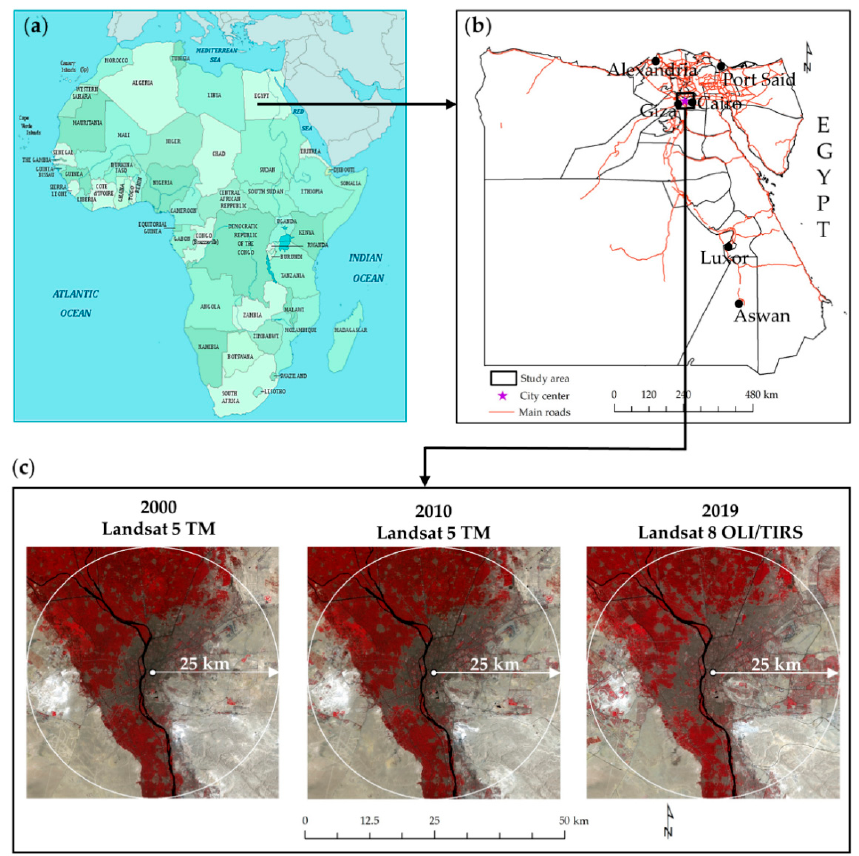
Figure 1. Location of Greater Cairo: ( a ) Egypt and other African countries [77]; ( b ) Egypt and Greater Cairo [78]; and ( c ) study area with 25 km buffer from the city center in 2000, 2010, and 2019. False-color band composites in 2000, 2010, and 2019 were downloaded from the Google Earth Engine (GEE) platform